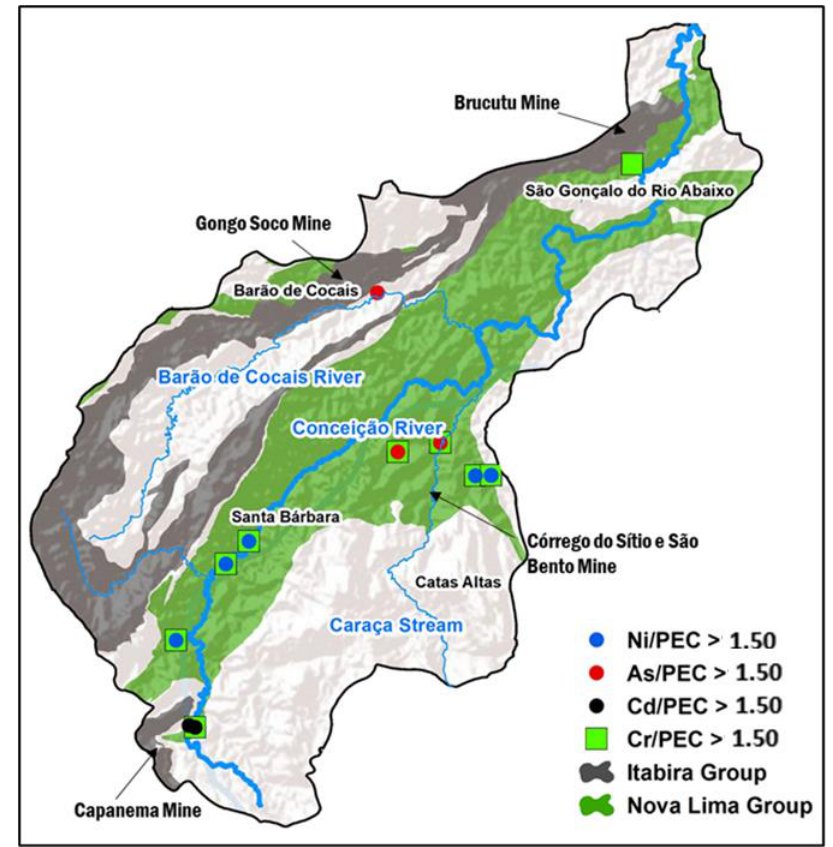
Figure 4. Spatial location of samples with a PEC ratio greater than 1.5.